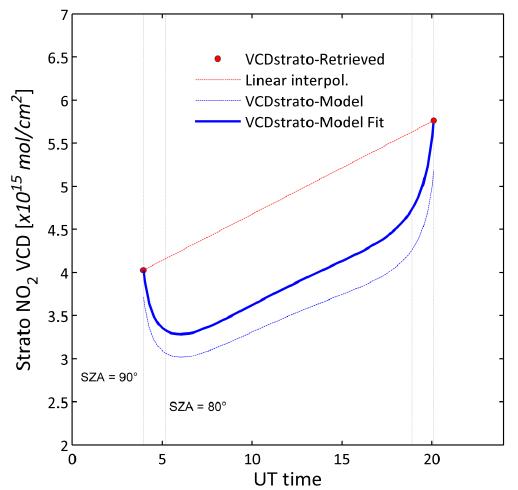
Figure 4. Representation of the retrieved stratospheric NO 2 VCDs at 90 ◦ SZA sunrise and sunset for reference day 174 (Sect. 3.4.1) and fit of the NO 2 diurnal cycle modelled with the photochemical model